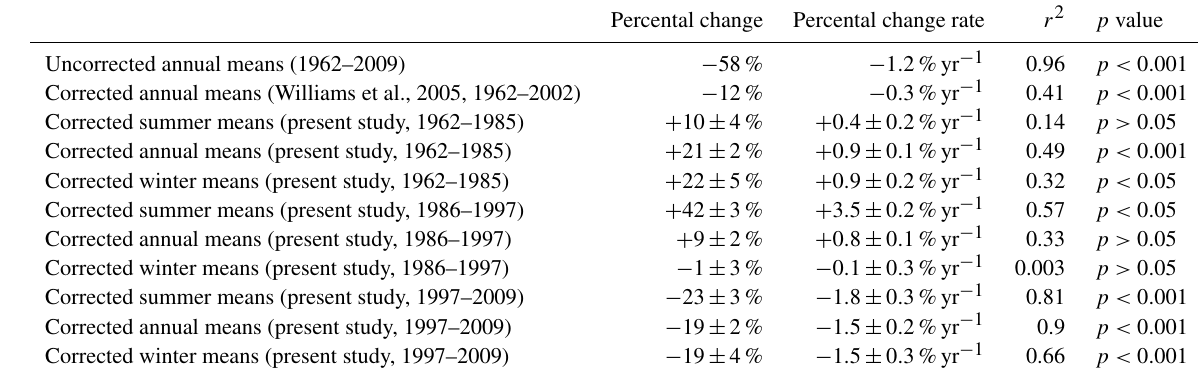
Table 3. Changes of PG at NCK as estimated by linear approximation. Percental change gives the ratio of the PG value estimated in the last year of the considered time period to the value obtained in the first year of the considered time period using linear approximation. Percental change rate is the percental change divided by the number of years in the considered time period. The uncertainties are deduced (propagated) from the uncertainties of the corresponding tree heights and linear fit and carry the uncertainties of the model.